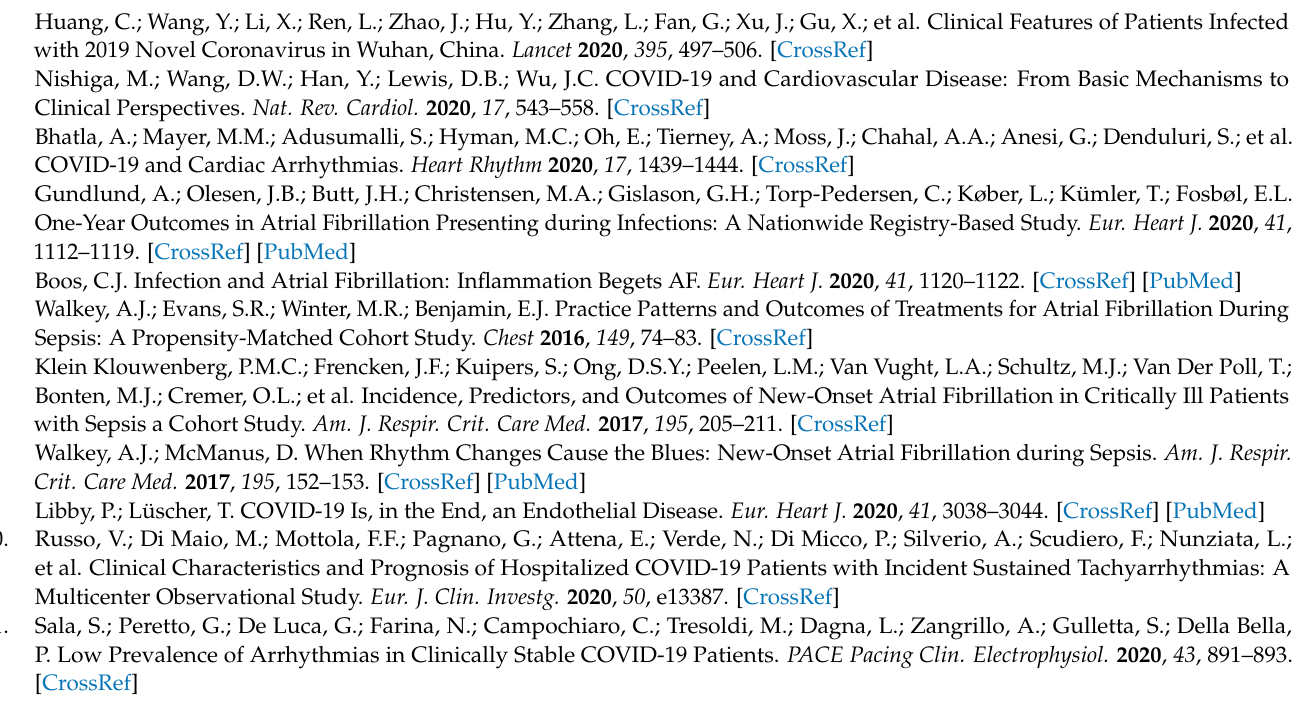
of AF, Table S3: Bias Assessment—NOS for outcomes according to AF, Table S4: Sensitivity Analysis for the prevalence of AF according to different analysis methods, Table S5: Pre-specified subgroup analysis for AF prevalence, Table S6: Univariable and Multivariable Meta-Regression Analysis for All-Cause Mortality, Figure S1: PRISMA Flow-Chart of the Study, Figure S2: Leave one out analysis for prevalence of AF, Figure S3: Leave one out analysis for all-cause mortality according to AF, Figure S4: Subgroup analysis according to definition of all-cause mortality (In-hospital mortality vs. 30-days mortality), Figure S5: Publication Bias for all-cause mortality according to AF, Figure S6: Sensitivity analysis on New-Onset